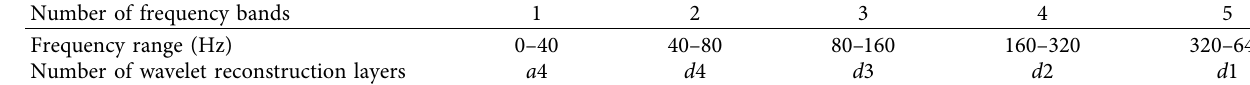
Table 2: Frequency range of each band and number of wavelet reconstruction layers.